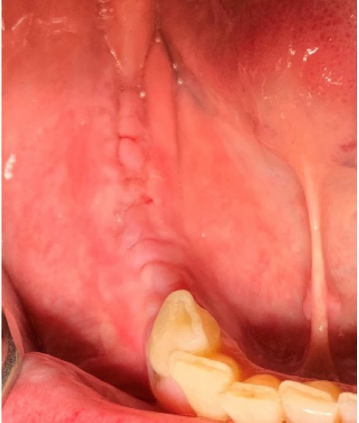
Figure 9. Follow-up after two